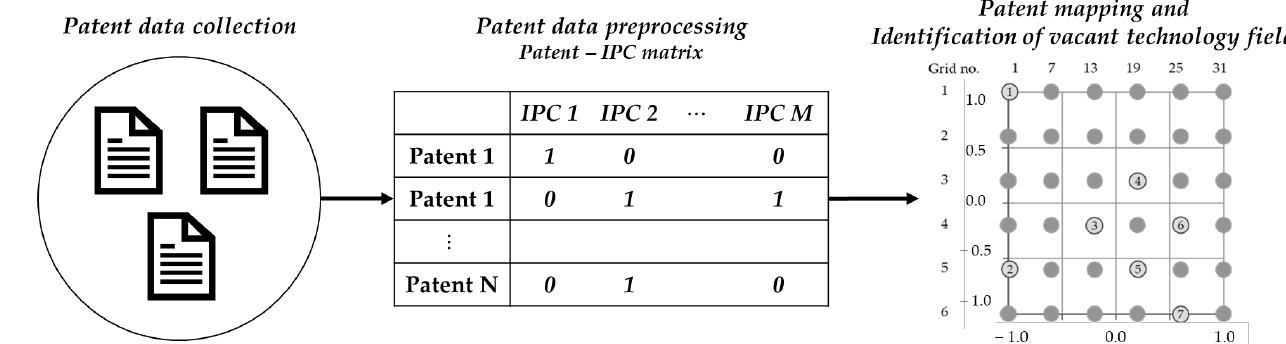
Figure 2. The process of identifying vacant technology fields.